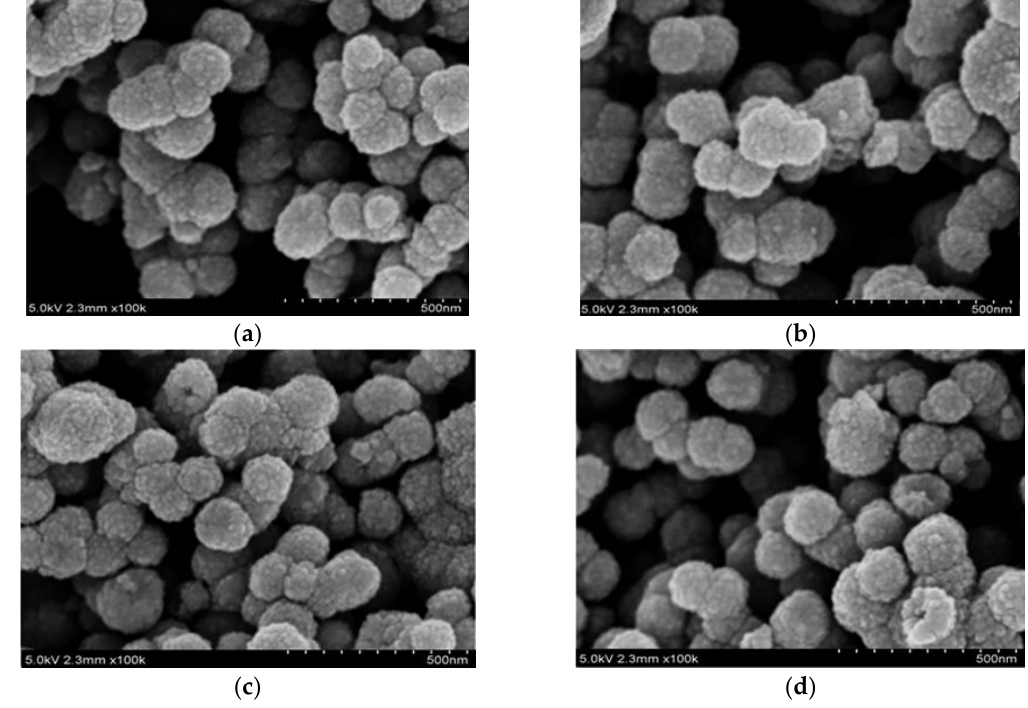
Figure 3. FESEM images of ( a ) pure; ( b ) 1 at.%; ( c ) 3 at.%; and ( d ) 5 at.% Ag doped SnO 2 .